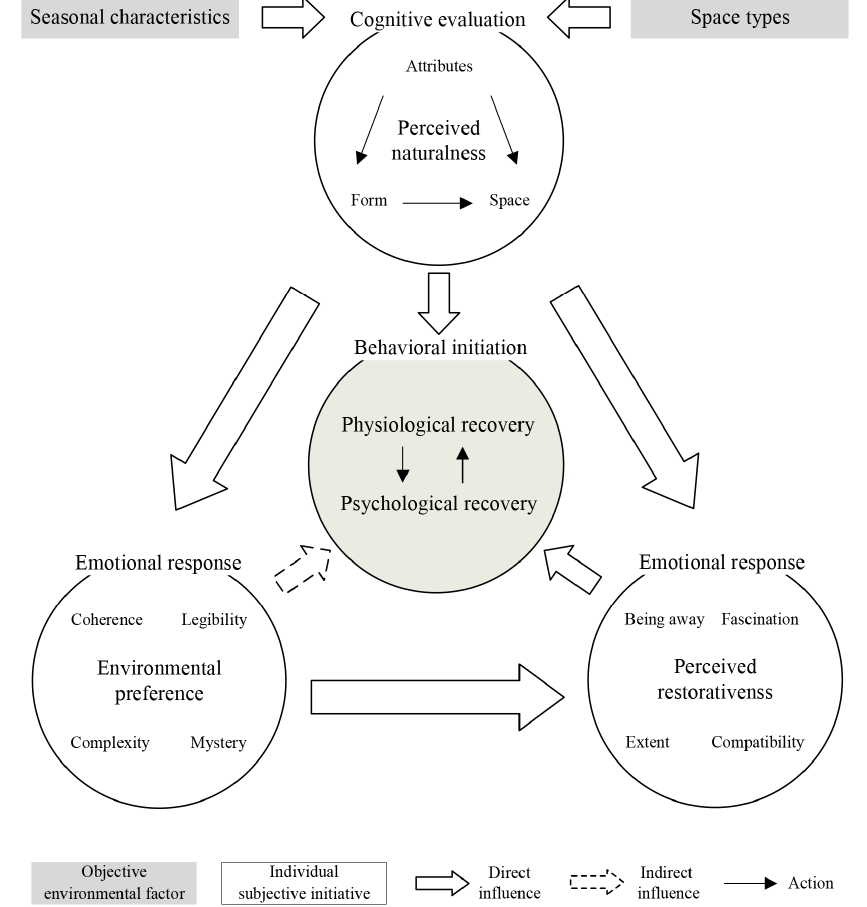
Figure 9. Effects of landscape perception on physical and mental recovery. This figure was created by Rui Chen. Rui